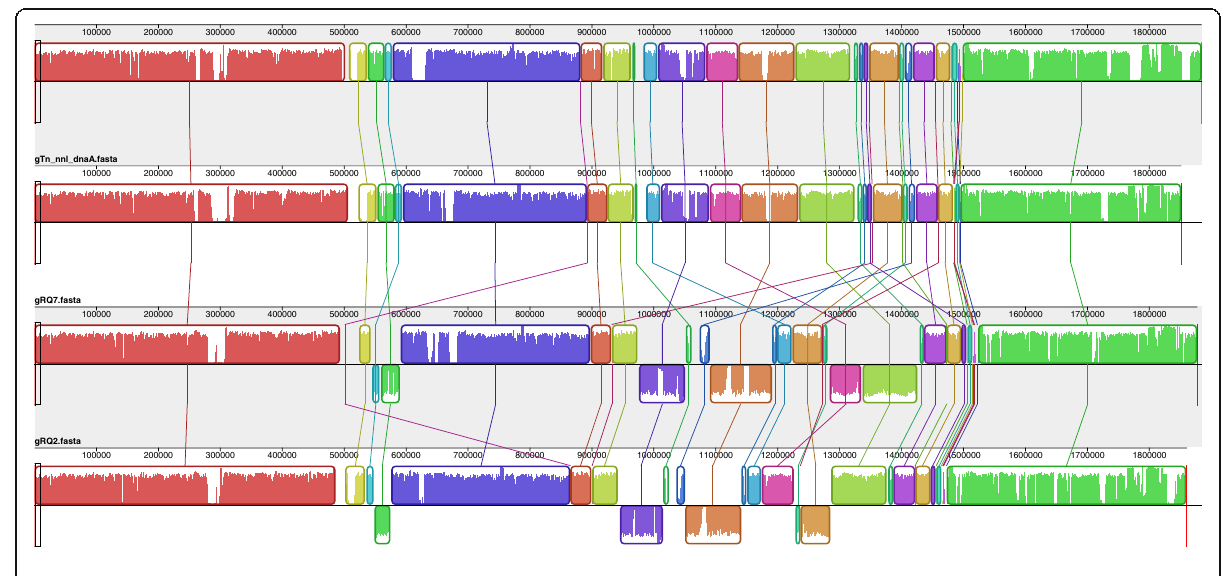
Fig. 4 Full genome alignment of the four Thermotoga strains using Mauve [53]. Each horizontal panel represents one genome sequence, from top to bottom: T. neapolitana DSM 4359, T. sp. strain RQ7, T. sp. strain RQ2, and T. maritima MSB8. The sequences were downloaded from GenBank, and genomes of T. neapolitana DSM 4359 and T. maritima MSB8 were re-linearized at the dnaA gene. Blocks with the same color represent homologous regions. Blocks below the center lines are inversed regions. Inside of each block, the height of the similarity profile corresponds to the average level of conservation of the local